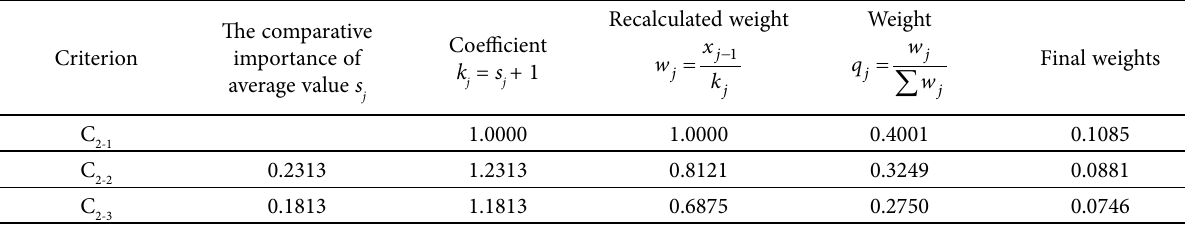
Table 7. Final results of SWARA method in weighting sub-criteria of economic